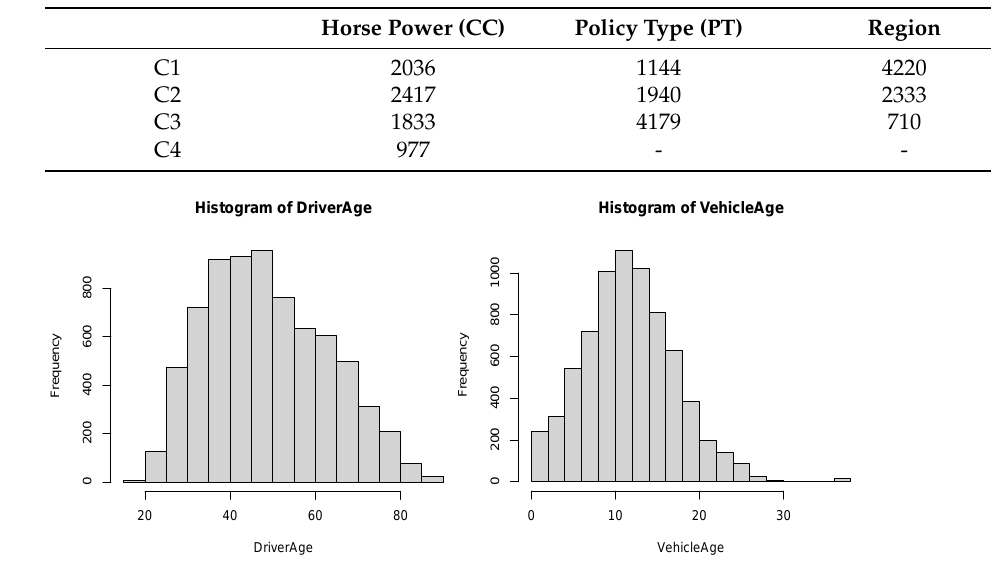
Table 2. Empirical distributions of categorical variables.